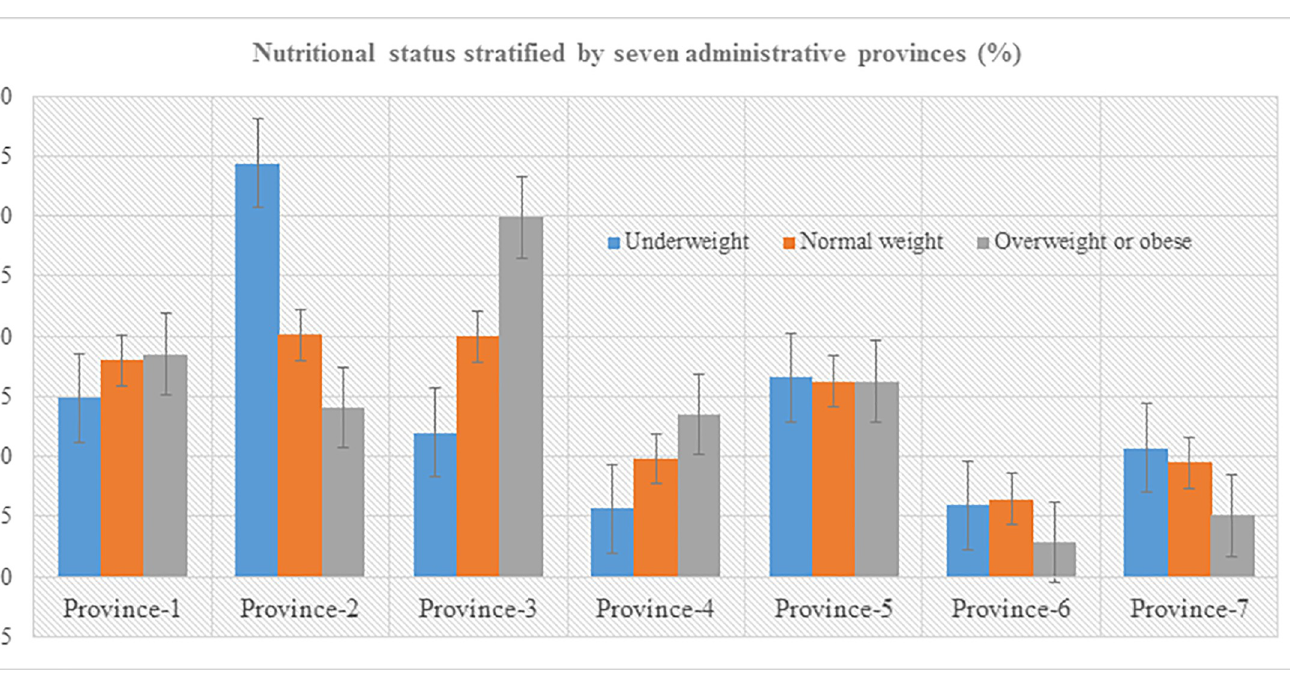
Fig 2. Nutritional status of the participants stratified by seven administrative